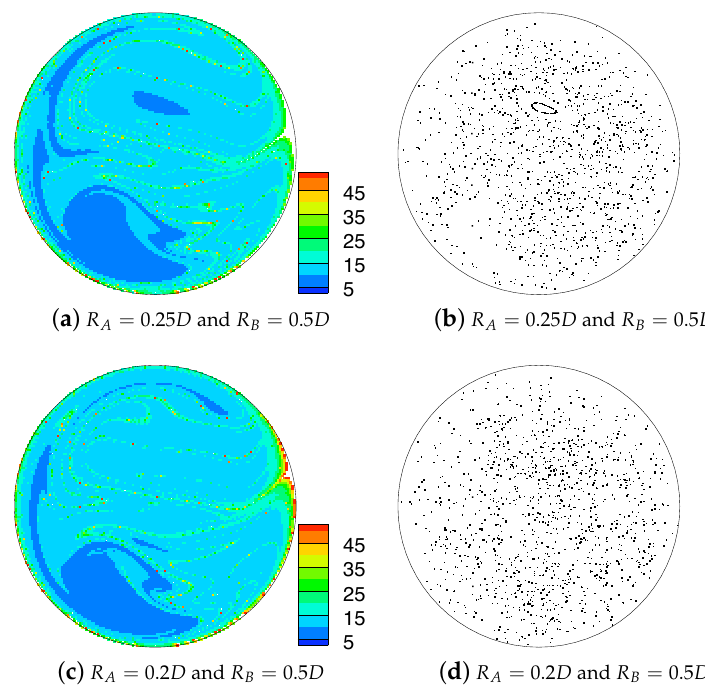
Figure 15. Residence time colour scatter plot ( left ) and Poincaré sections ( right ) obtained from particle tracking performed on the velocity field directly computed over the entire combined geometries. A correspondence in structures between the two plots can be observed for R A = 0.25 D and R B = 0.5 D in ( a , b